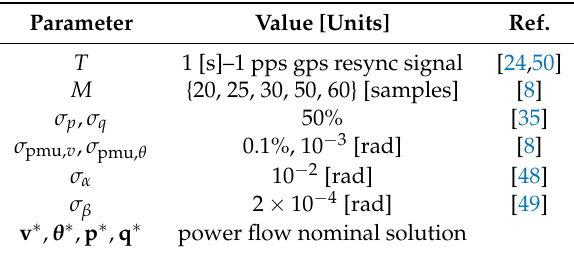
Table 1. Parameters used in the simulations.